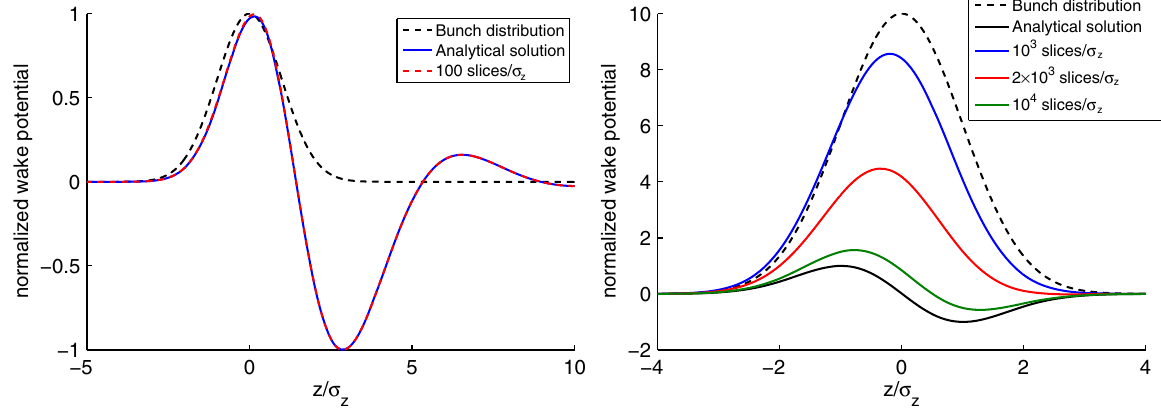
FIG. 1. Normalized wake potential of a broadband resonant mode given by Eq. (5) with a different number of slices compared with the analytical solution of the convolution integral of Eq. (3) for a Gaussian bunch with length of 2 cm (left side) and 2 m (right side). The normalization constant is the maximum value of the analytical